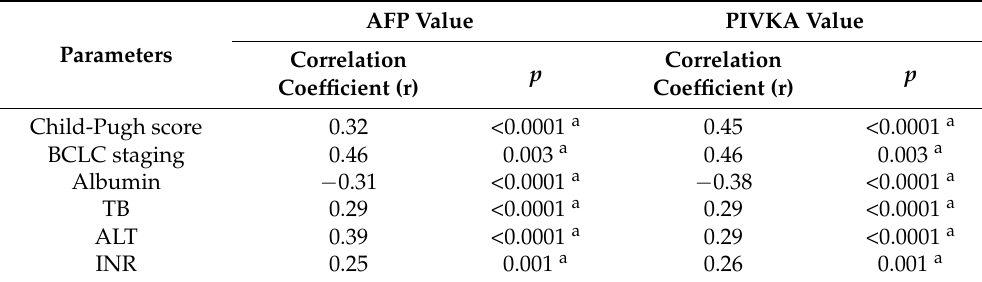
a by Spearman Correlation coefficient. Correlation is significant at the 0.05 level (2-tailed).